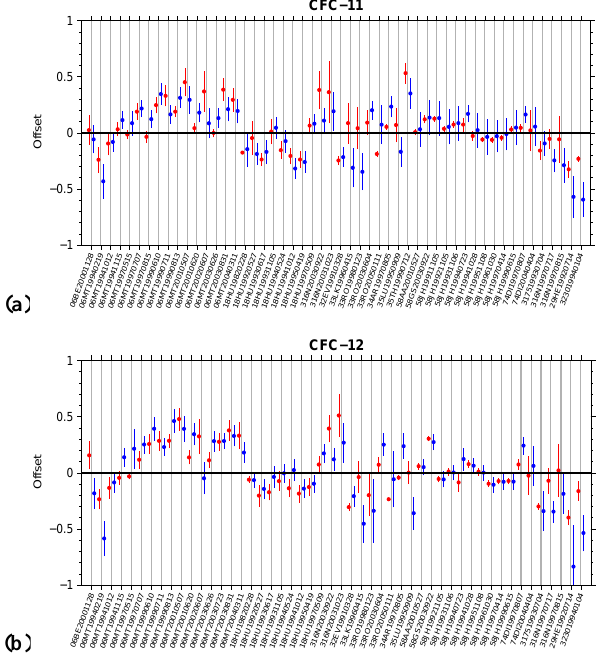
Figure 4. Mean value for all crossovers of each cruise (red) and o ff sets from the least square crossover analyses (blue) as suggested by the LSQ inversions for all CFC-components from the CARINA- ATL data set. Vertical lines denote the error range (standard devia- tion for the mean values and statistical uncertainty for the o ff sets). Some cruises of the Arctic / Nordic Seas region and non-CARINA data are included to get an overlap between the regions and provide consistency towards other data sets. (a) CFC-11, (b) CFC-12, (c) CFC-113, (d) CCl 4 .